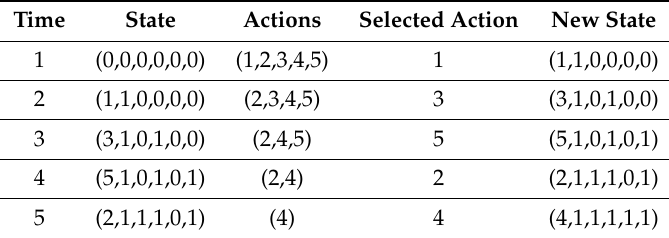
Table 1. A simple agent